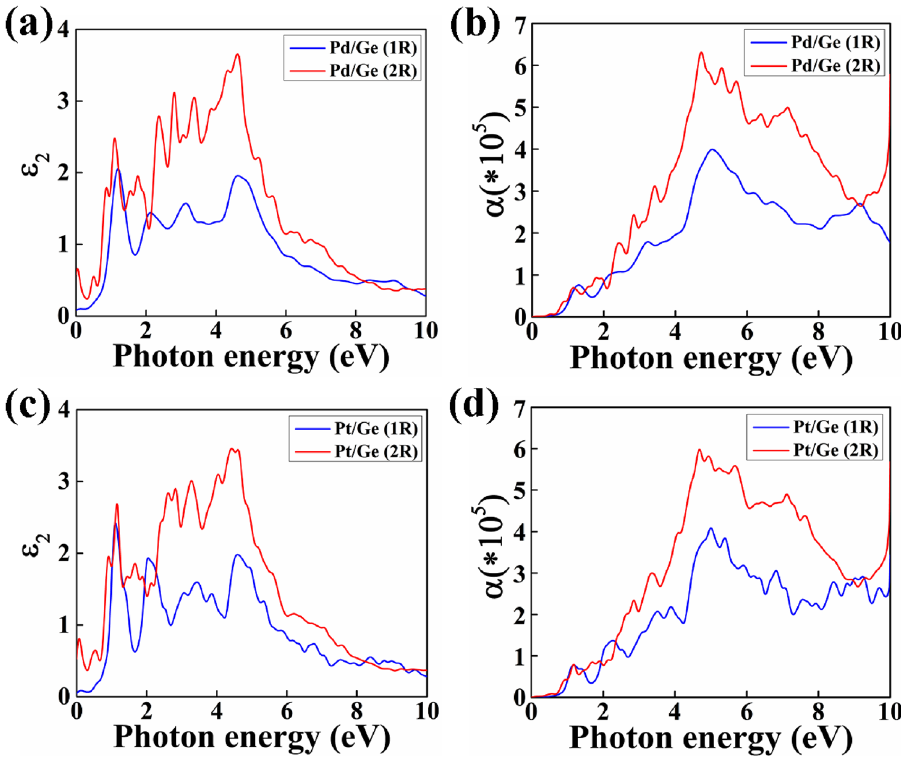
Figure 5. The diameter dependent imaginary part of the dielectric constant ( Ɛ 2 ) with photon energy and its corresponding adsorption co-efficient are shown in ( a , b ) for Pd/Ge and ( c , d ) for Pt/Ge core/shell